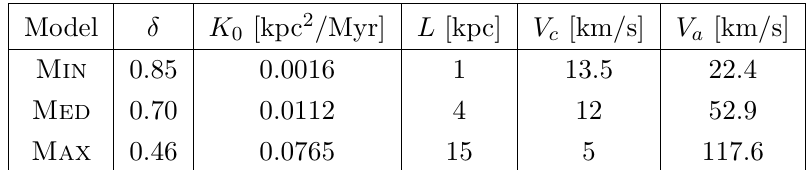
Table 2 . Benchmark Min , Med , and Max sets of propagation parameters